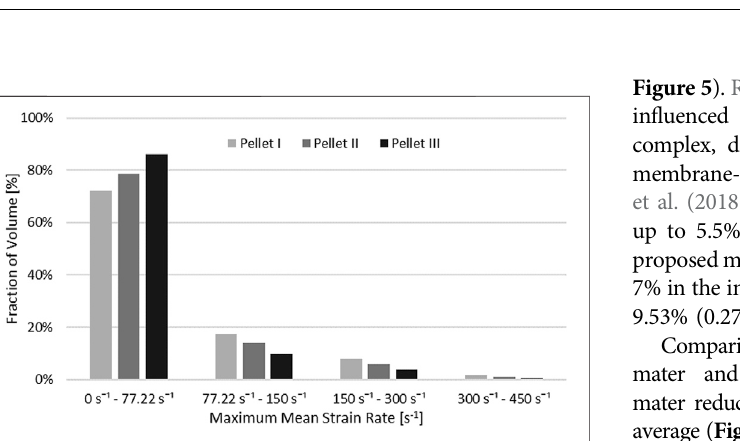
Frontiers in Bioengineering and Biotechnology |